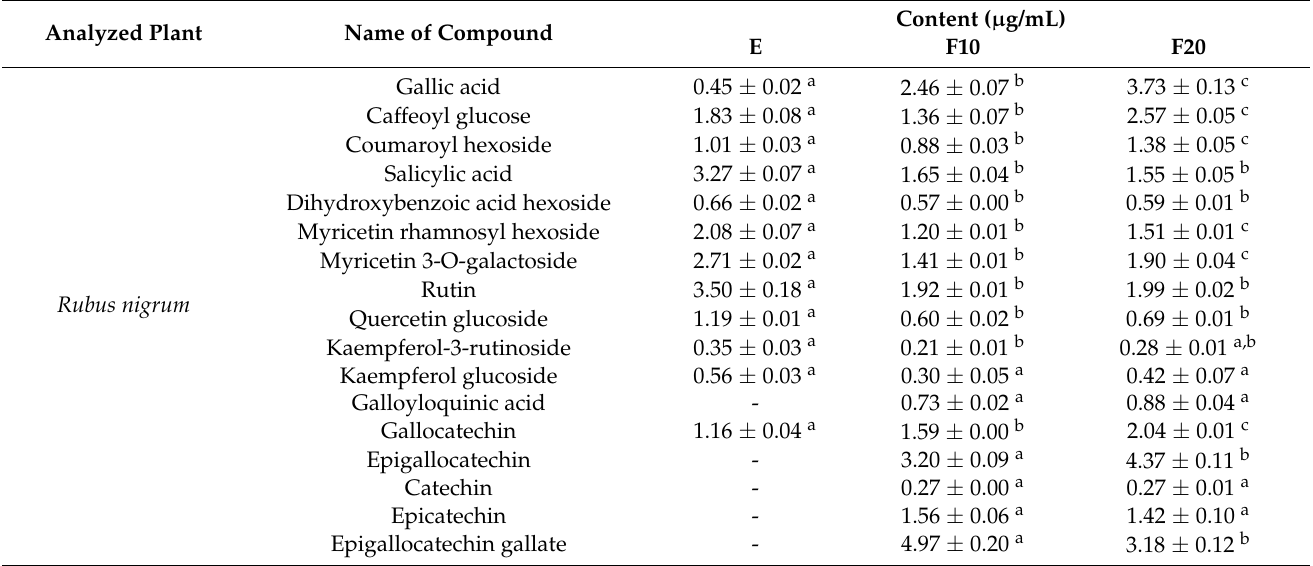
Table 2. UHPLC/DAD/ESI-MS quantitative analysis of R. nigrum , A. melanocarpa , and V. myrtillus water extracts and kombucha ferments. Values are means ± standard deviation (SD) of